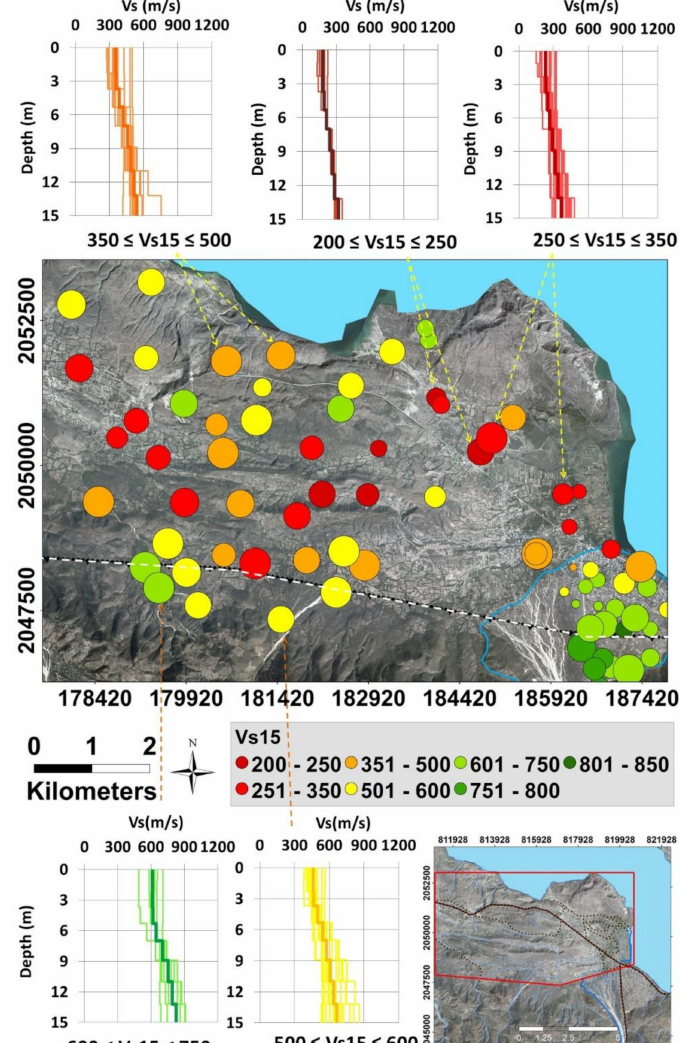
Figure 6. Vs profiles determined for the central and western part of Fond Parisien (down to a depth of 15 m). Vs15 values are represented in the central map by colors for each investigated site. See also the approximate location of the EPG